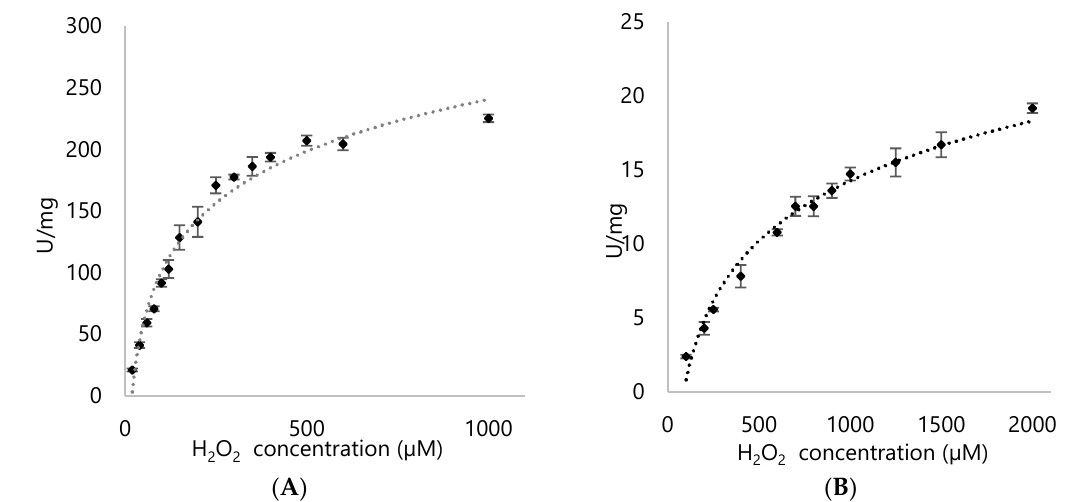
Figure 8. Michaelis-Menten kinetics of ( A ) DypA and ( B ) DypB with varying concentrations of H 2 O 2 (20 µM to 1000 µM) in Reactive Blue 5 assay.